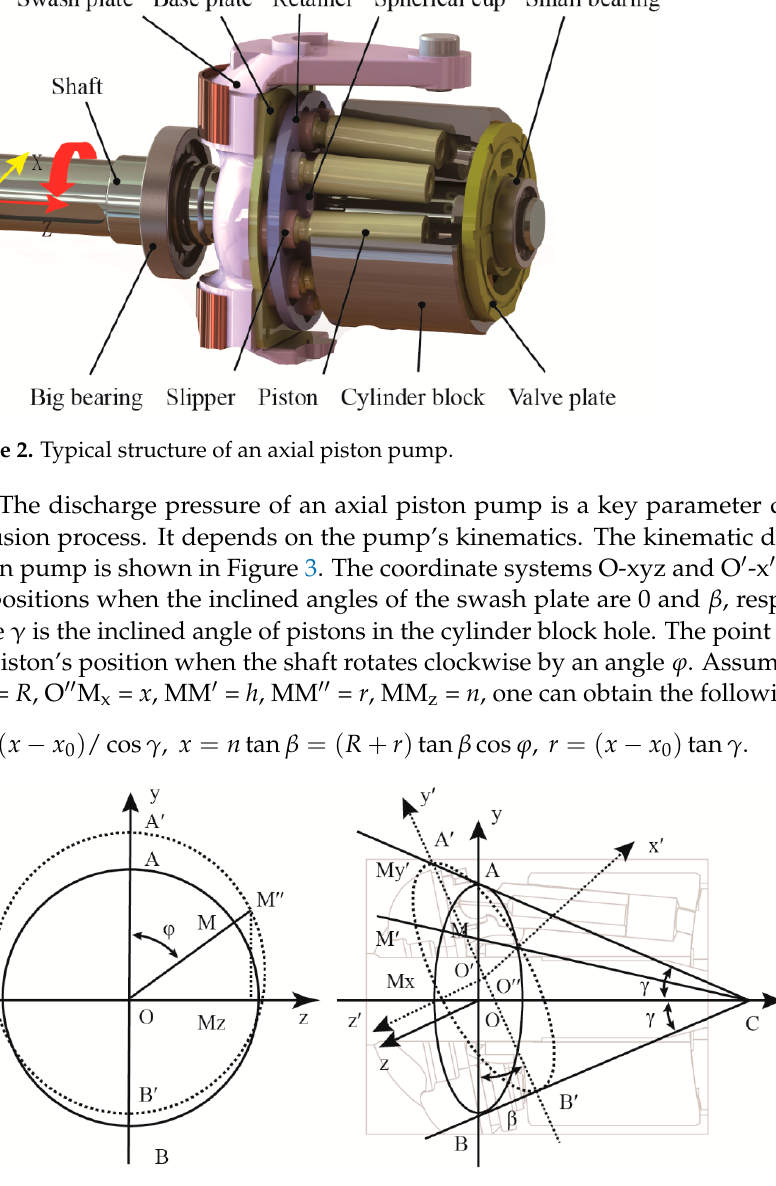
Figure 3. Kinematic diagram of an axial piston pump.